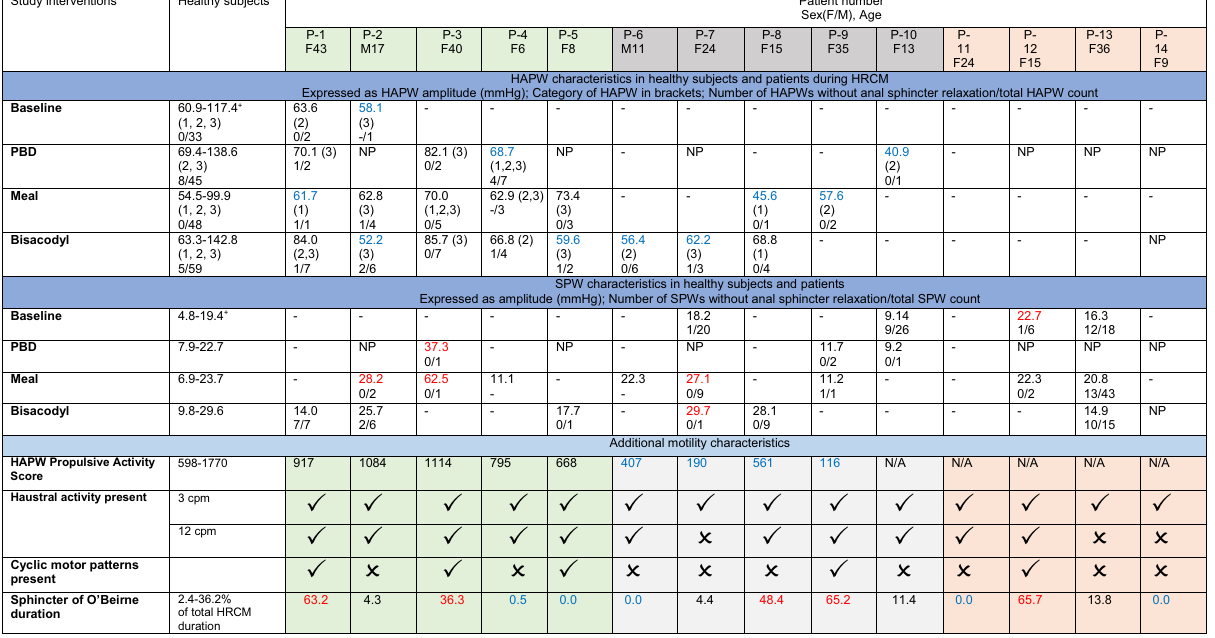
(Table 1, Fig. 1). The amplitudes of HAPWs were significantly lower in patients in comparison to healthy subjects (Fig. 1B,C, Table 1). Generation of HAPWs via the vagal pathway.